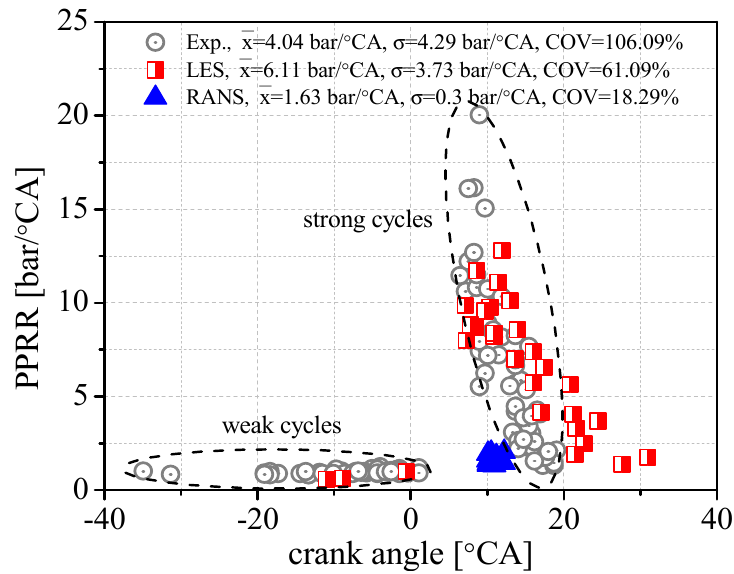
Figure 5. The scatter plot of the in-cylinder peak pressure rise rate (PPRR) and the corresponding crank angles.